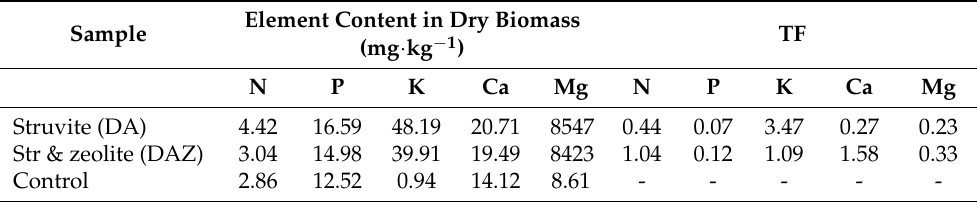
Table 5. The results of nutrient uptake by cucumber fertilized with struvite fertilizer.